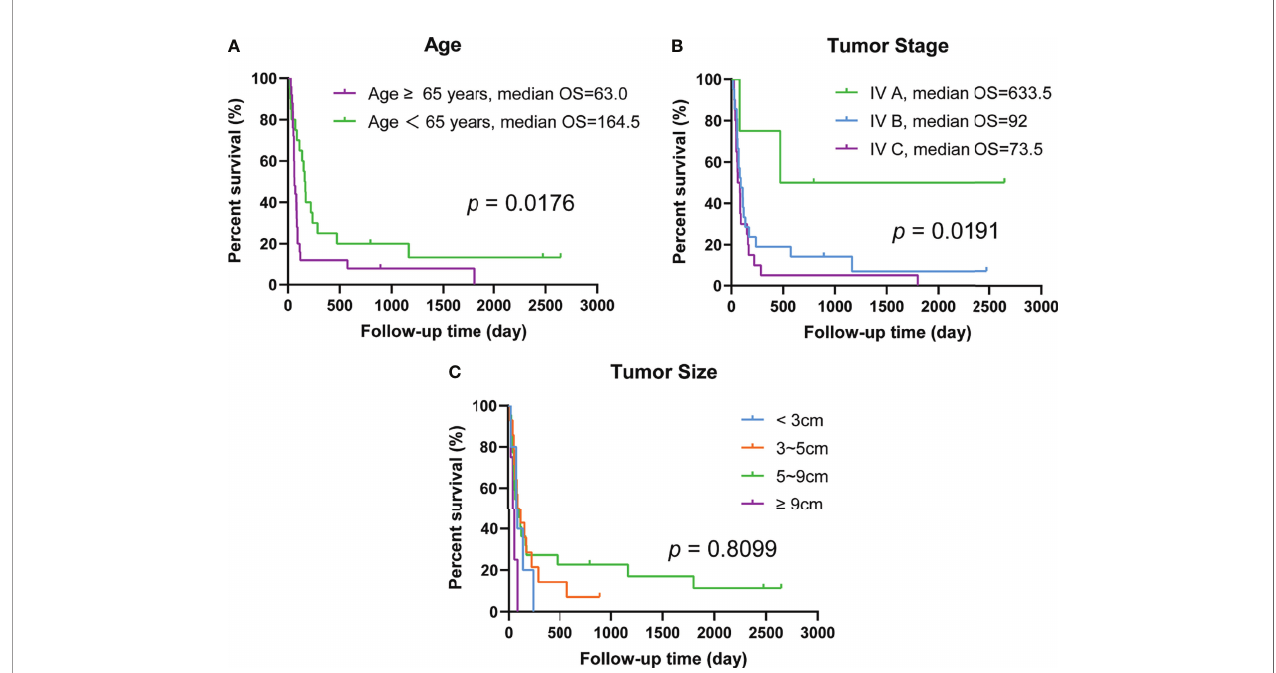
FIGURE 1 | Prognostic analysis of anaplastic thyroid carcinoma patients ’ baseline characteristics. (A) Differences in survival days between age ≥ 65 years and age <65 years. (B) Differences in survival days among different tumor stages. (C) Differences in survival days among different tumor